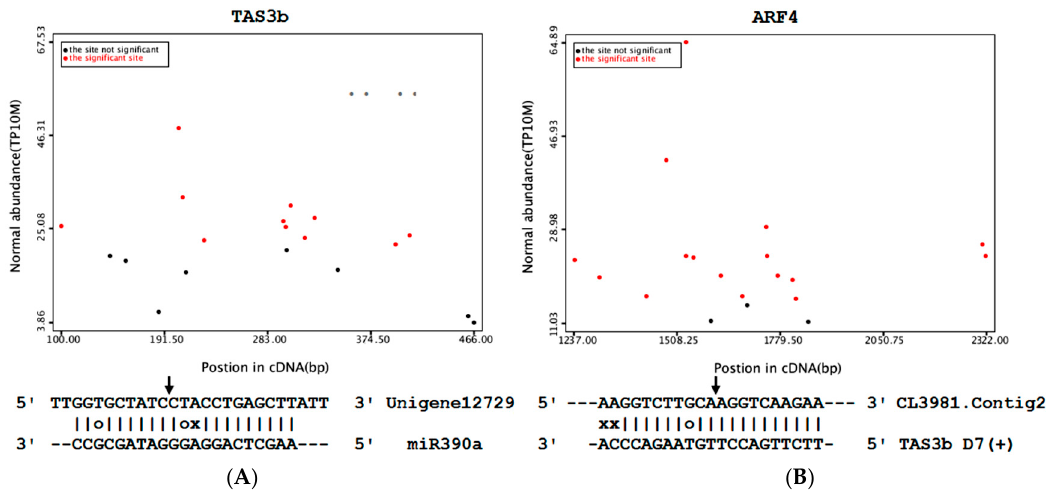
Figure 8. Target plot (t-plot) for cotton TAS3b ( A ) and ARF4 ( B ). Arrows indicate the signatures corresponding to the cleavage site. Partial mRNA sequences of target genes aligned with small RNA show perfect matches (straight lines), G-U wobbles (circles).